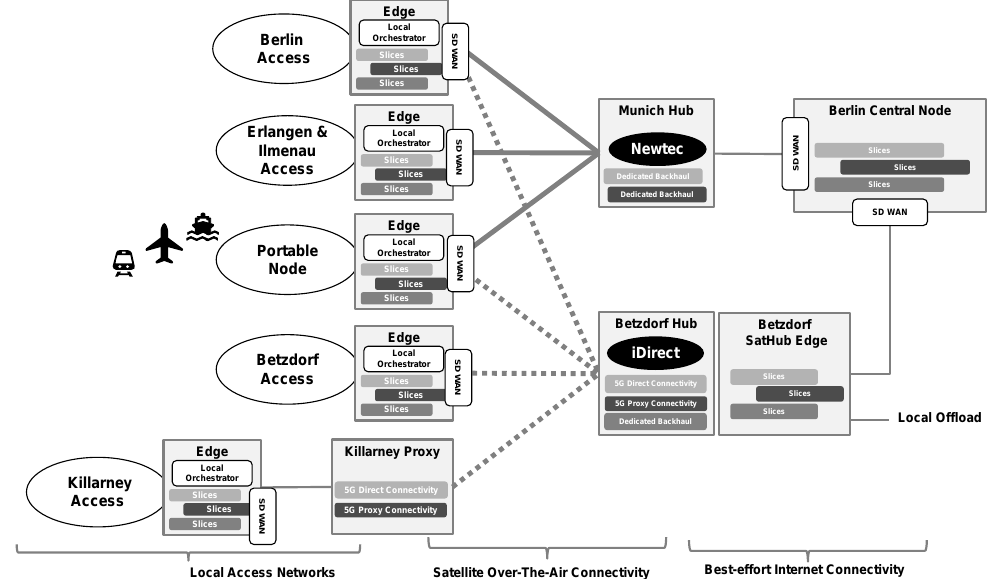
Figure 6. Final terminal deployment for the